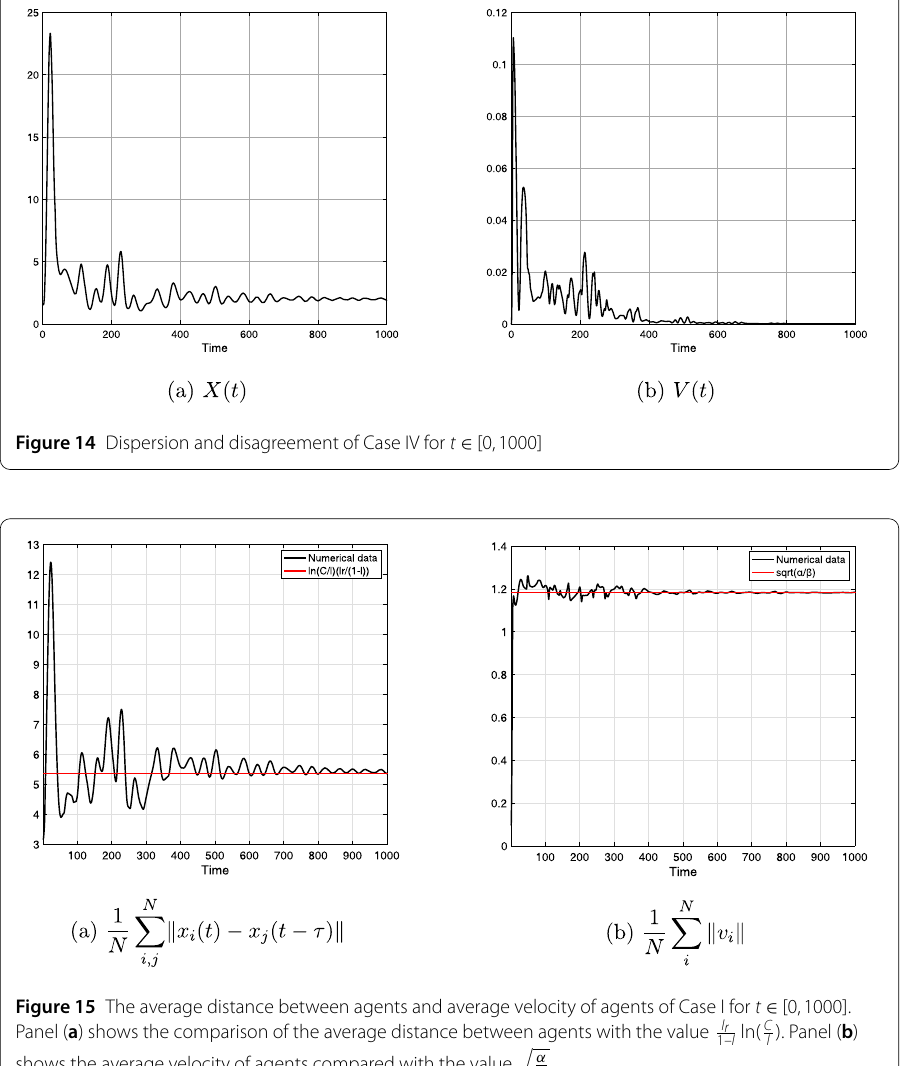
ln( C ). Panel ( b ) (cid:16) 1– l l α